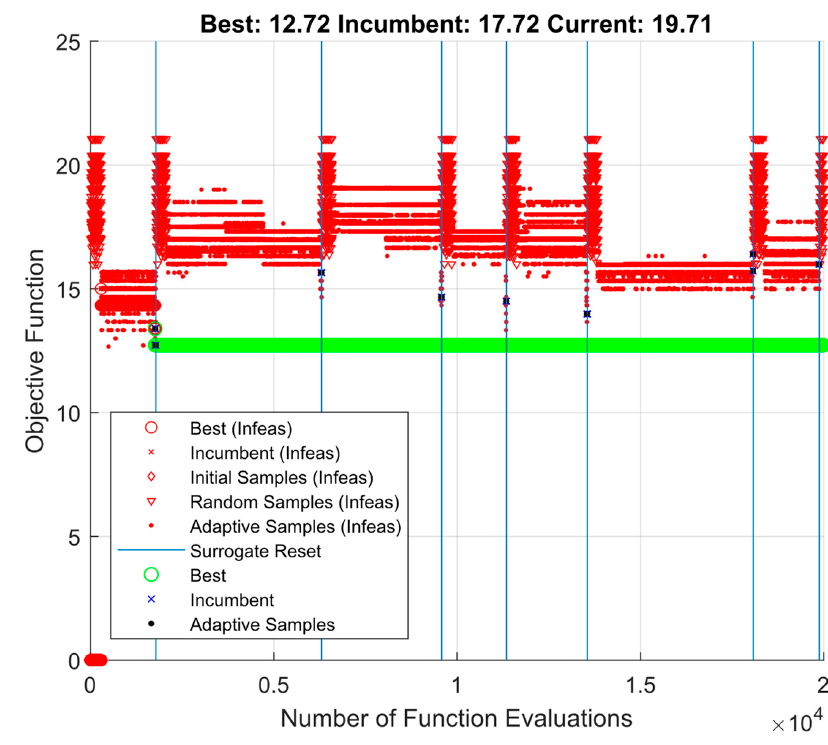
Figure 4. Solution of the task (Variant #1).